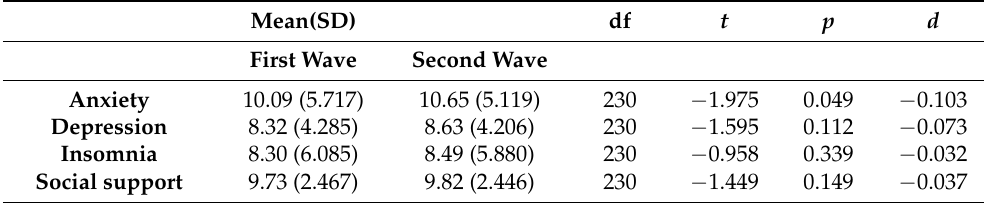
Table 4. Paired sample t -test to compare psychological impact during first and second wave of